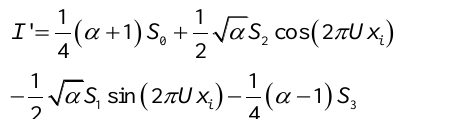
, and the interference patterns simulated under different beam splitting ratios are shown in Figure 2. (Picture on the right in the red dotted line is a partial enlargement of the interference